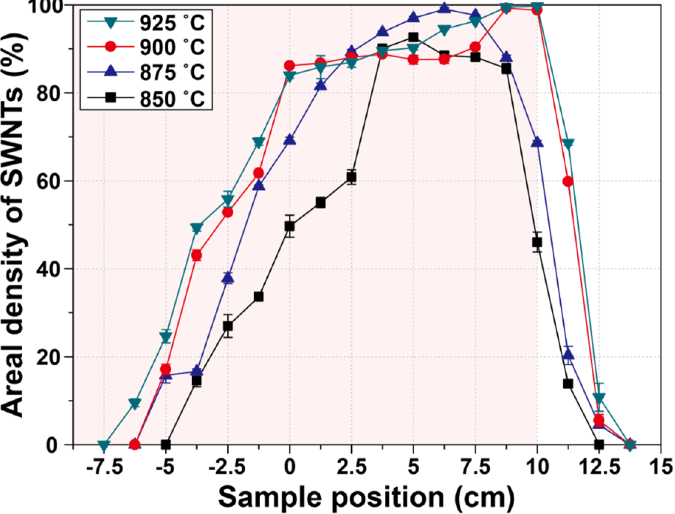
Figure 5. Variation of the areal density of SWNTs with respect to growth temperature and sample position.